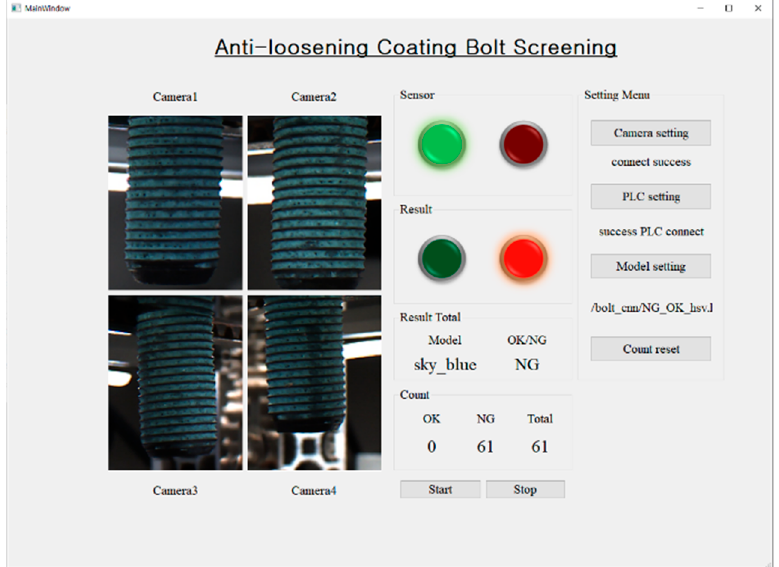
Figure 9. GUI for anti-loosening coating bolt screening. NG, defective product; OK, non-defective product.